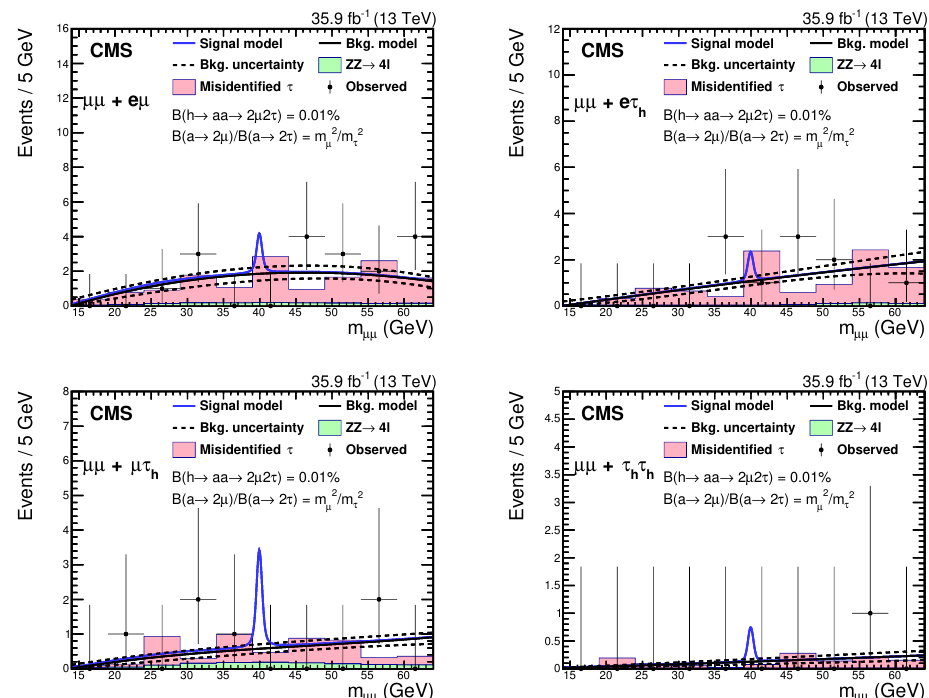
Bkg. uncertainty